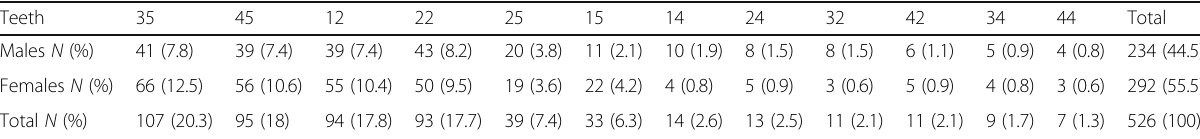
Table 2 Ranking of the most frequent missing teeth divided between sexes Teeth